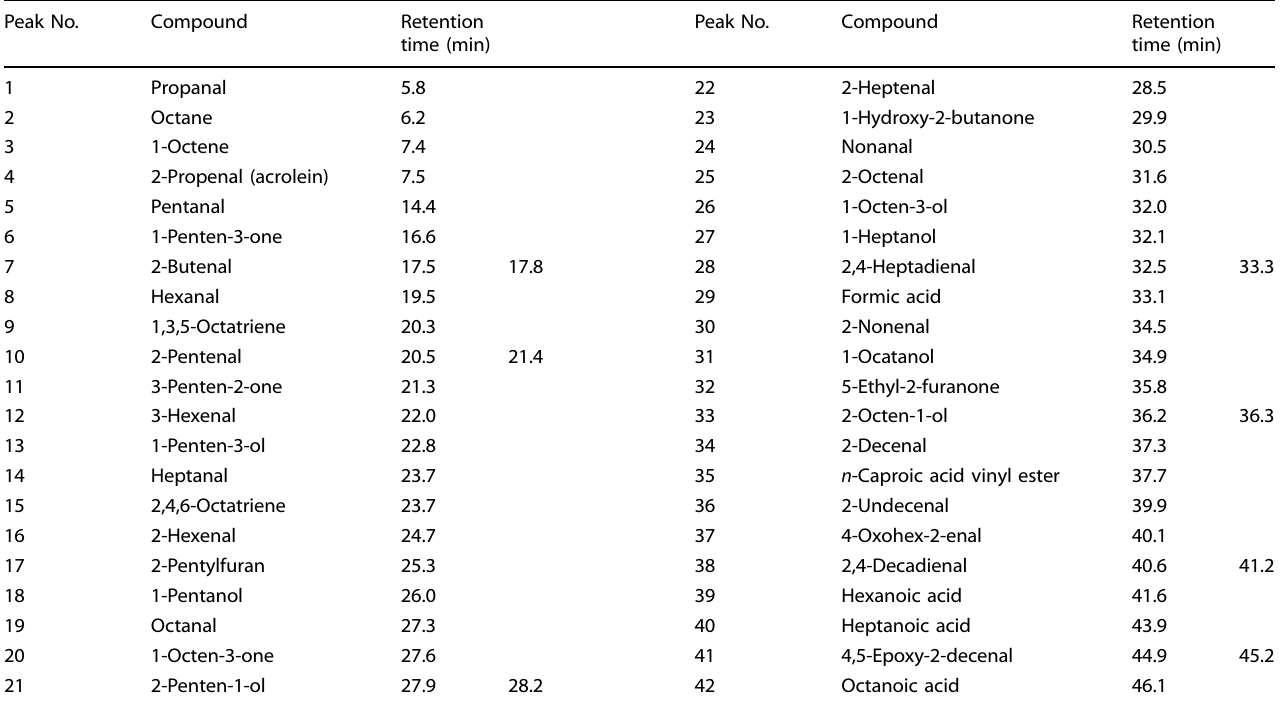
Table 1. Volatile compounds derived from FAOOH